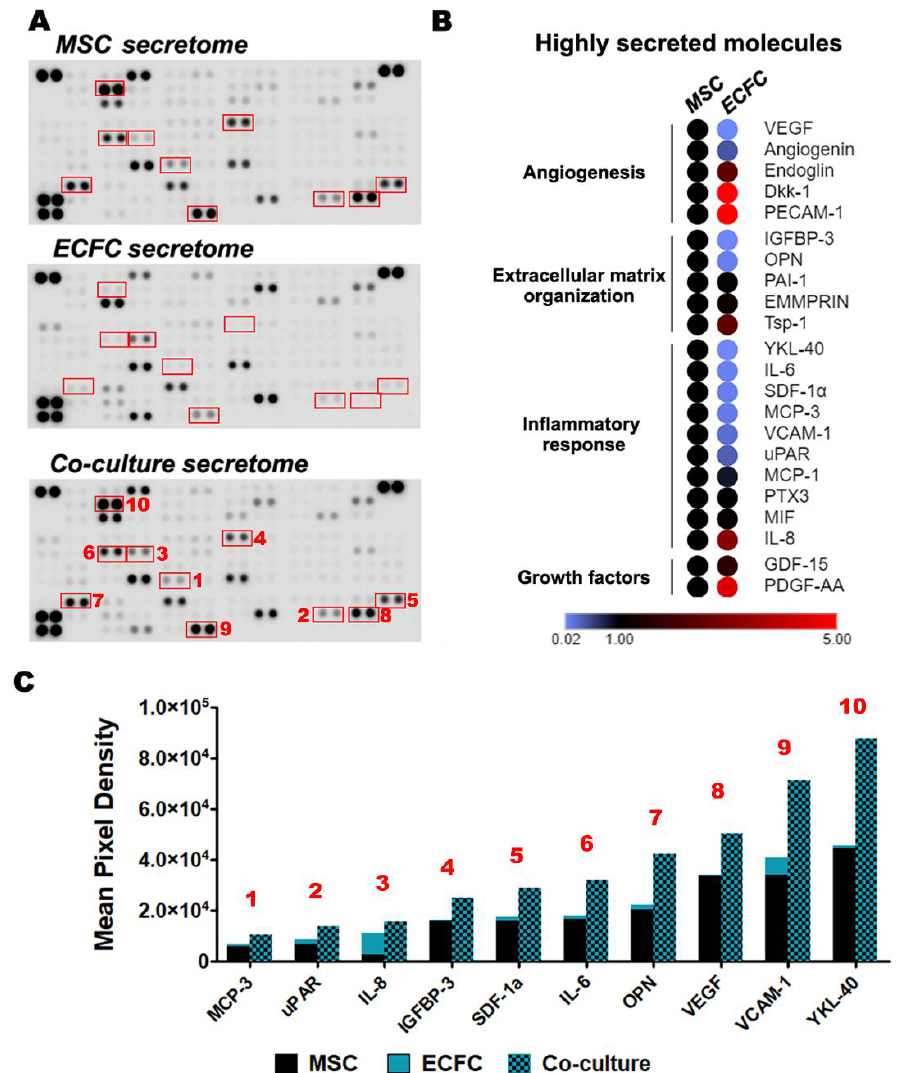
Figure 4. Proteome array analysis of the secretome produced by MSC and ECFC co-cultured in direct contact. ( A ) Secretory profiles of MSC, ECFC, and MSC + ECFC co-cultures were identified by antibody-based Human XL Cytokine Array. Shown in red are proteins whose cumulative levels were induced following co-culture as compared to their expected levels; ( B ) heatmap representation of the highly secreted cytokines, illustrating the major secretion source and biological processes associated to the cytokines; ( C ) the relative levels of proteins in the co-culture supernatant, which were found to be induced by more than 35% after MSC-ECFC co-culture.